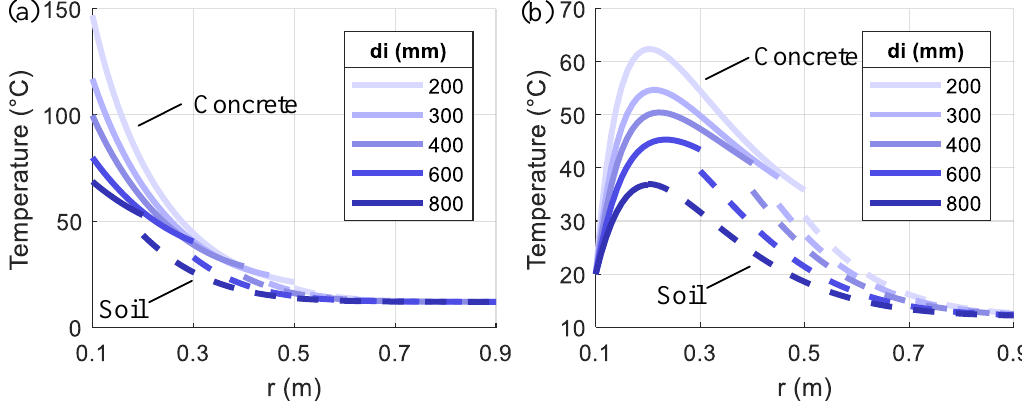
Figure 14. Temperature distribution in the first loading cycle for different d i at: ( a ) 19:00; ( b ) 7:00 (end of the loading cycle).